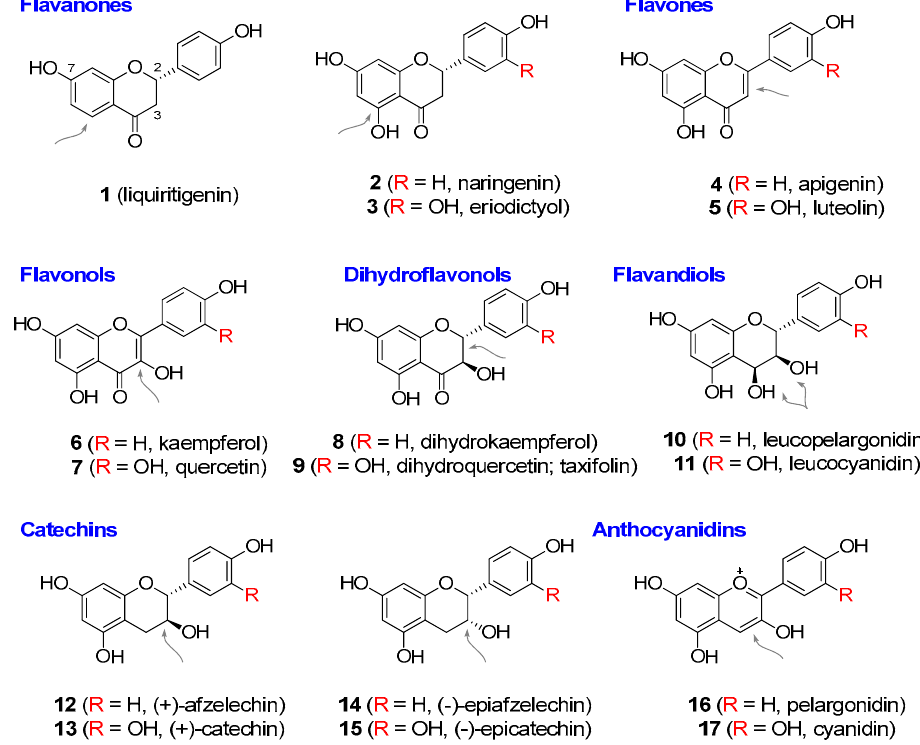
Figure 2. Molecular structures of the common flavonoids.